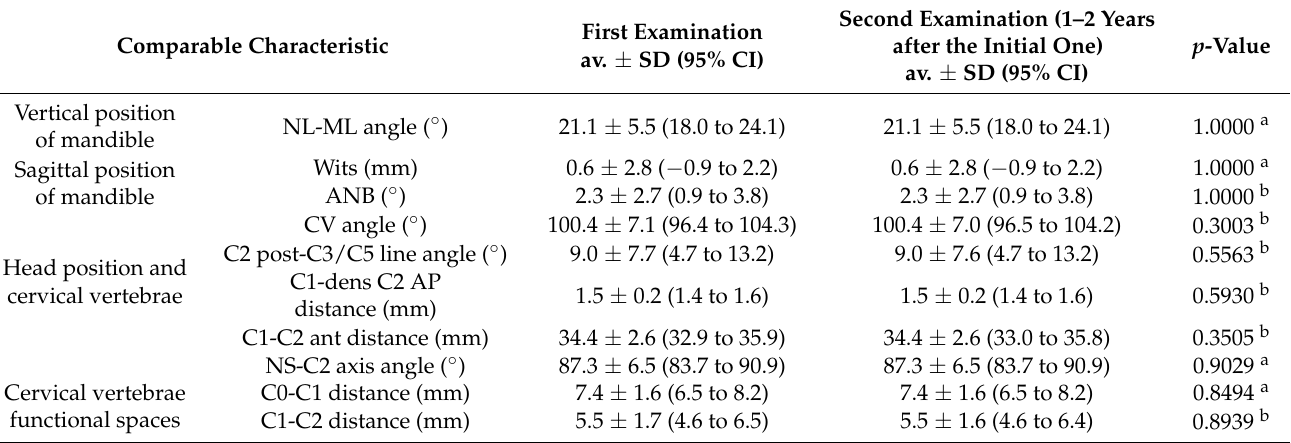
Table 4. Assessment of changes in the cervicofacial skeleton that occurred between the first and the second orthodontic examination in the control